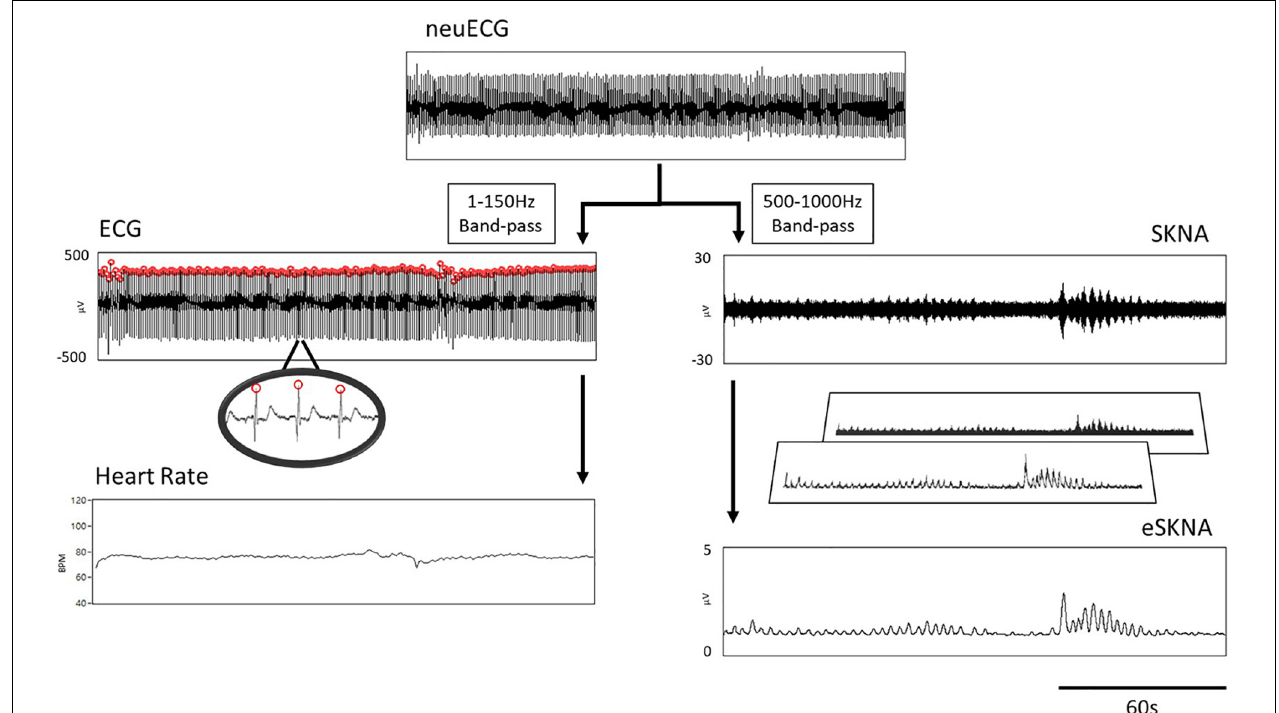
FIGURE 1 | Flow chart of signal processing. The neuECG passed through a 1- to 150-Hz bandpass filter to show the ECG, which was processed by an R-wave peak detector to calculate heart rate (left path). The 500–1000 Hz signals were extracted by digital filtering to present the SKNA (right path). The final output of signal processing is the envelope of SKNA